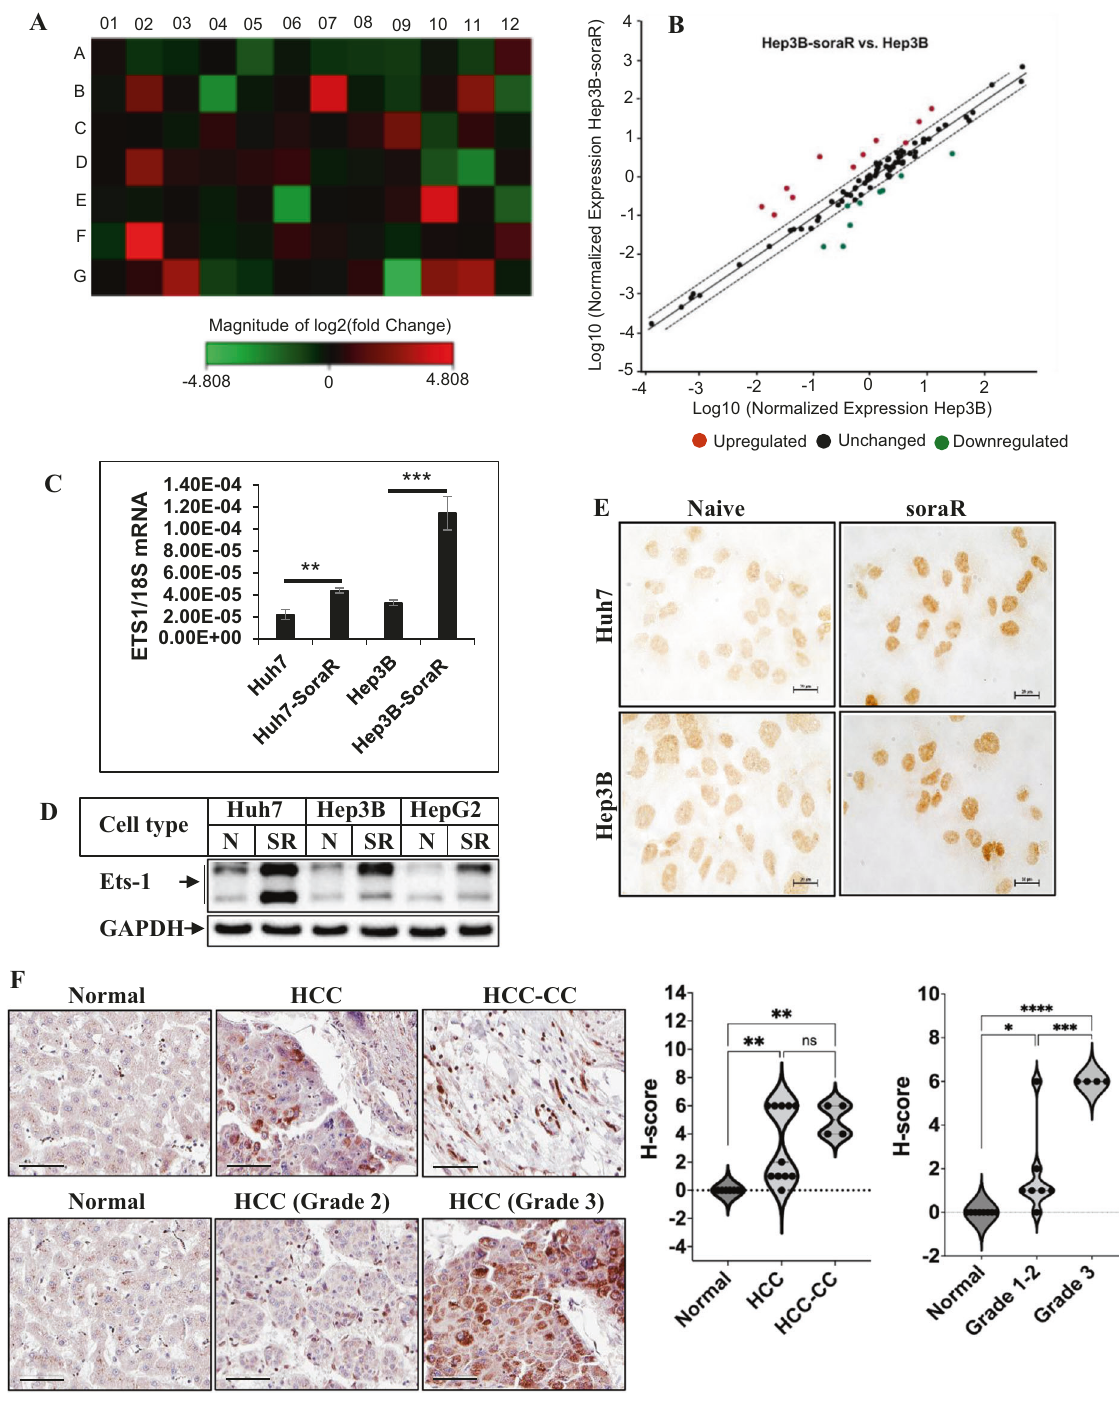
Fig. 3 Transcription factor Ets-1 expression is induced in soraR cells. A Total RNA extracted from Hep3B-naive and soraR cells was subjected to cDNA synthesis and analyzed with human transcription factors PCR Array (PAHS-075Z). Figure in A shows the heat map with the upregulated genes marked in red and the downregulated genes marked in green. B shows the scatter plot of expression levels of 84 genes. Red dots indicate genes upregulated and the green dots indicate the genes downregulated. The central line indicates genes that were unchanged (black dots) with dotted lines indicating the selected twofold regulation cut-of. C Changes in the expression of ETS-1 gene in Huh7 and Hep3B (naive and soraR) cells were analyzed by qPCR. The data represent the mean ± S.D. of 3 independent PCR reactions, and the experiment was repeated three times. D Equal amounts of total protein from 3 sets of naive (N) and soraR (SR) HCC cells were analyzed by western blots with antibodies against Ets-1 and GAPDH. E Immunocytochemistry showing differences in expression of Ets-1 in naive and soraR cells. The images were captured using the NIS-Elements imaging software in Nikon Eclipse Ti Microscope. Scale bar, 20 µm. F Representative images of immunohistochemistry of Ets-1 using liver cancer tissue microarray (US Biomax, # T031b). Scale bar, 60 µm. The Ets-1 staining intensities in the TMA were scored and plotted to the right. Statistical signi fi cance was determined by Tukey ’ s multiple comparisons test. * p < 0.05, ** p < 0.01, *** p < 0.001, **** p < 0.0001, ns: p > 0.05 not signi fi cant. HCC-CC hepatocholangiocarcinoma.